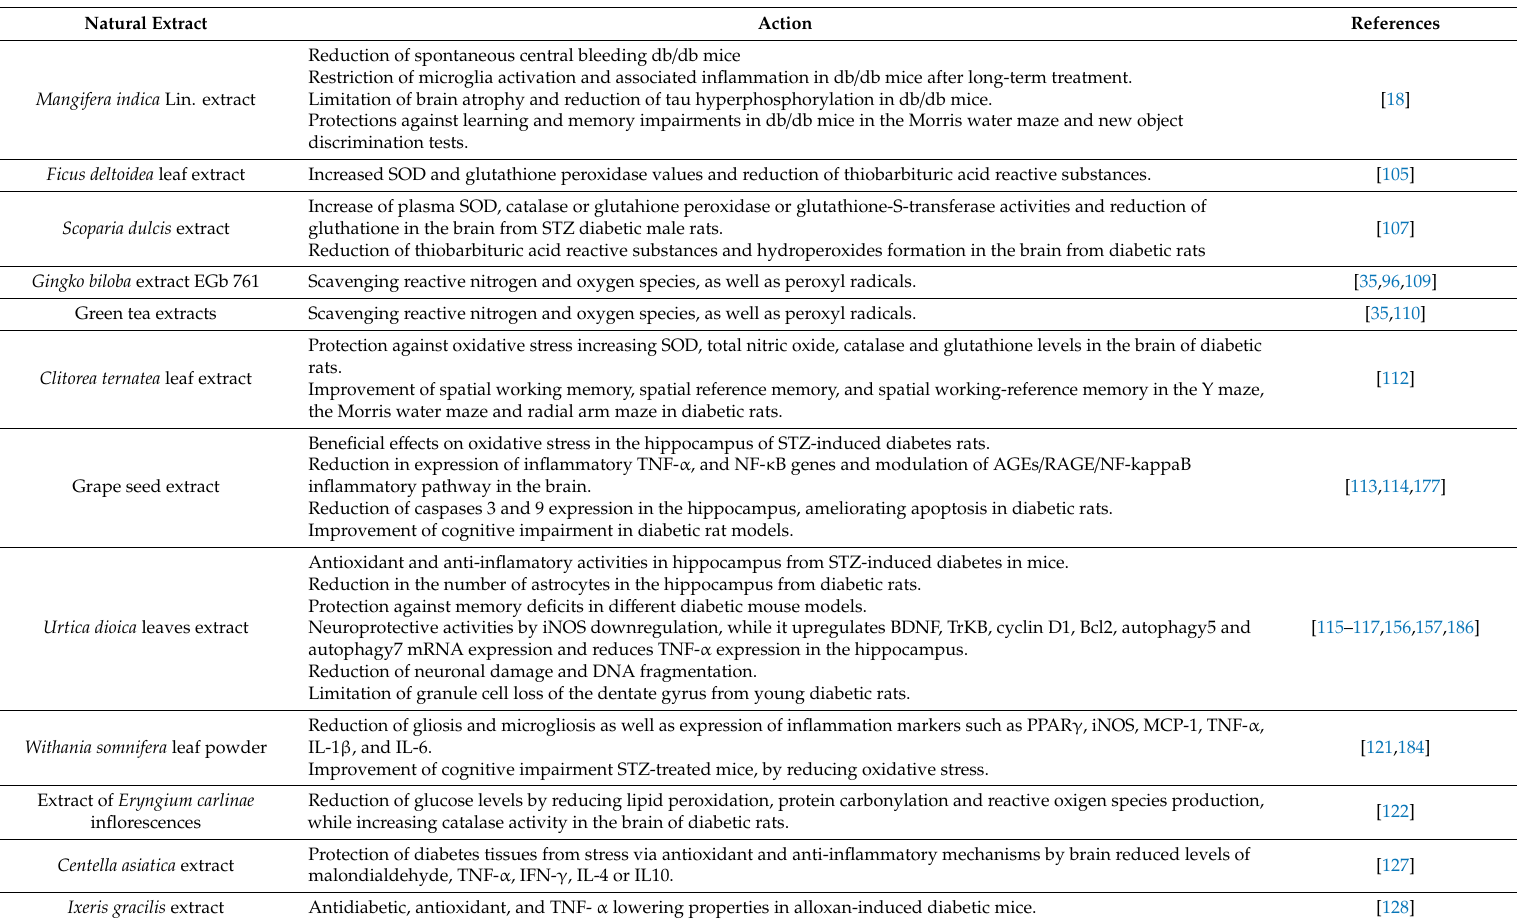
Table 2. Natural extracts with activity at central level associated with metabolic